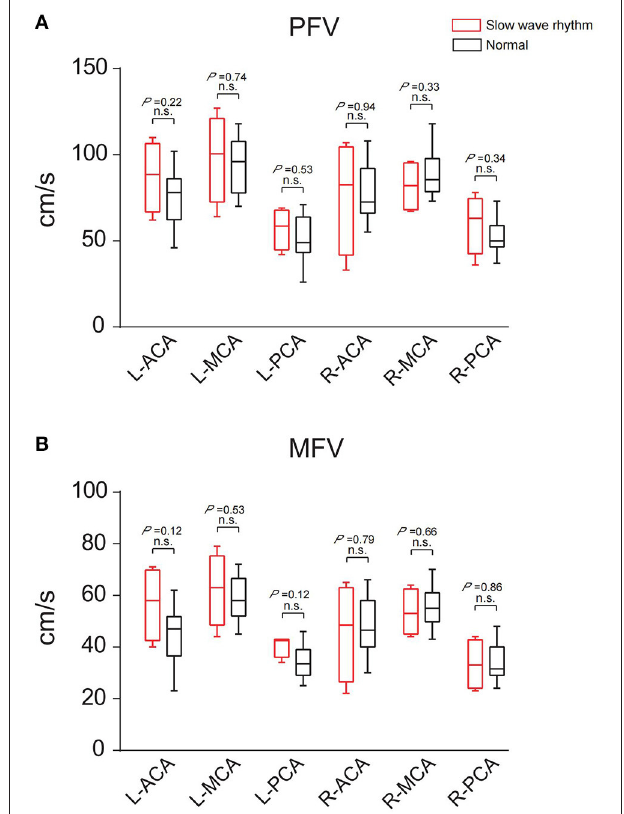
FIGURE 6 | The PFV and MFV of the same blood vessels in the two groups with slow background rhythm and normal background rhythm were compared. (A) PFV. (B) MFV. n.s., no statistical significance; R, right; L, left; ACA, anterior cerebral artery; MCA, middle cerebral artery; PCA, posterior cerebral